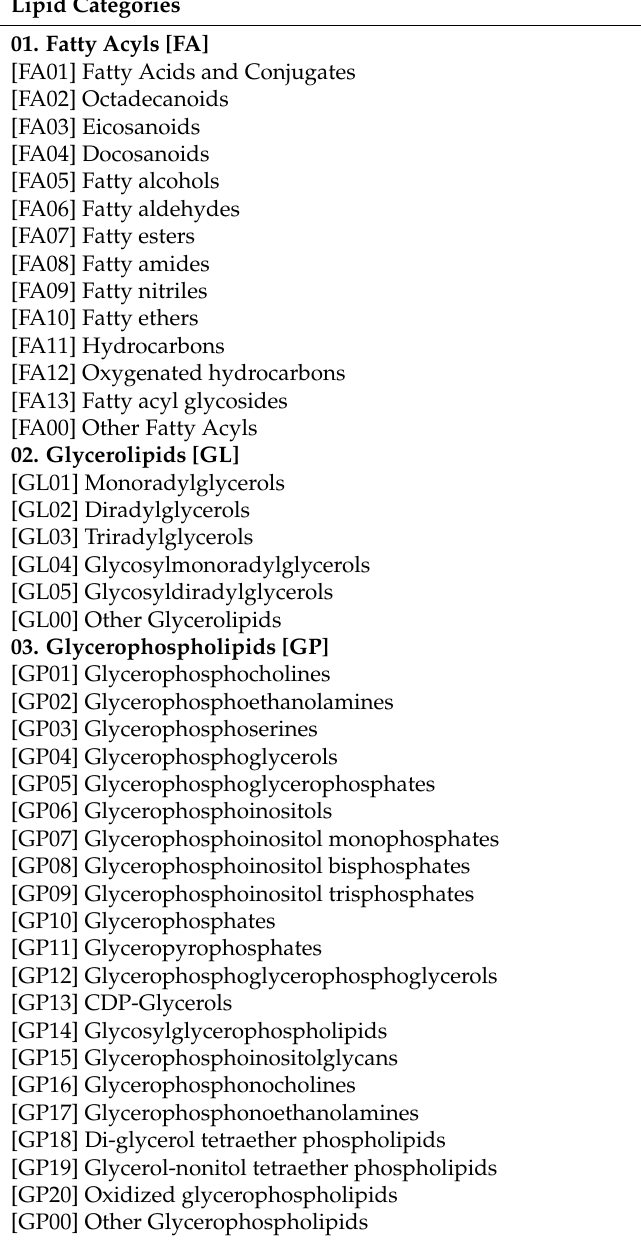
Table 1. Lipid classification based on Lipid Maps Structure